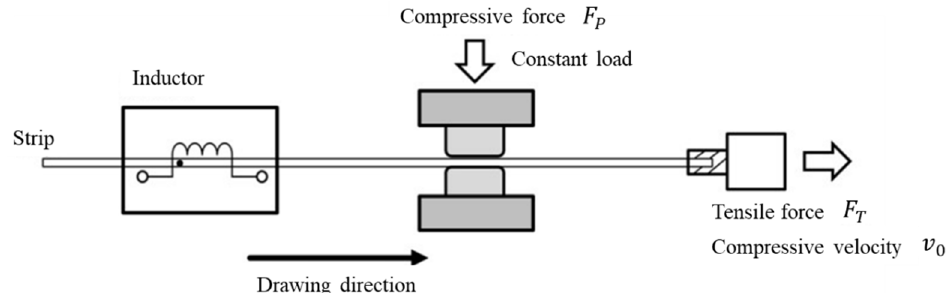
Figure 1. Flat drawing test machine scheme.